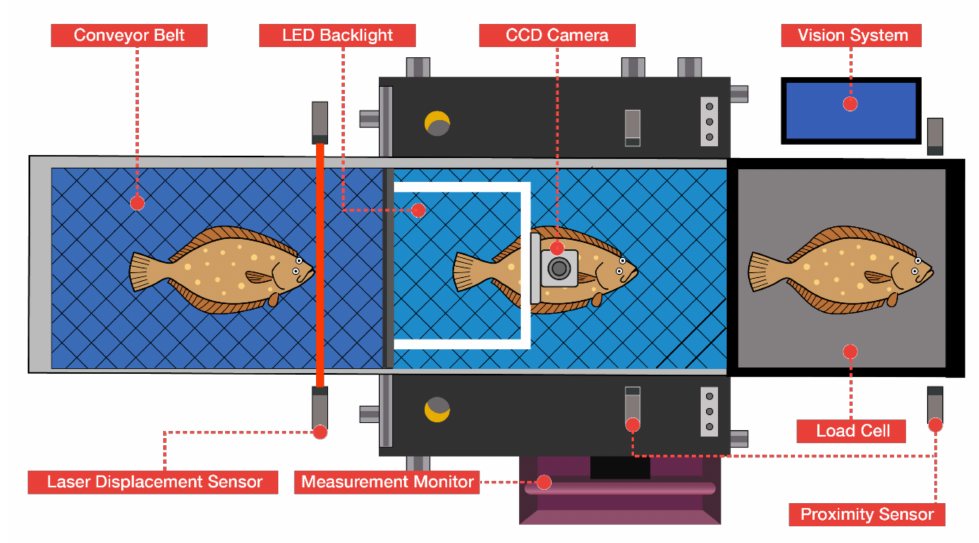
Figure 13. Conceptual diagram of a database management system for fishery resources management. In addition, Gerami et al. [88] assess the weight of salmon fish using machine vision. The fish samples were collected from a fish farm in Iran. There are 75 live specimens of rainbow trout ( Oncorhynchus mykiss). A digital Cannon IXUS 960IS (12 mega pixels; 3000 × 4000) in the red, green and blue channels was used to take photo from left side of samples. The camera was located above the sample at a height of 45 cm. All taken fish photos can be transmitted to computer and analyzed by MATLAB (Matrix laboratory) version R2009x (Figure 14) [88].